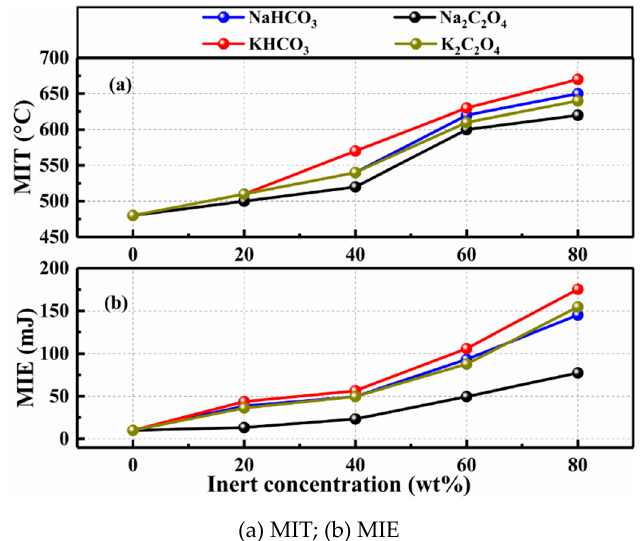
Figure 5. Effect of the concentration of four inert powders on the MIT and MIE of polyethylene (PE).